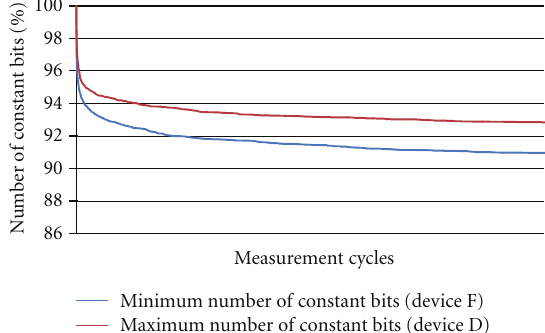
Figure 4: Percentage of constant bits over 10,000 measurements for two devices, that represent the maximum (device D) and minimum (device F) over all devices. All other values reside in the area between the two curves.